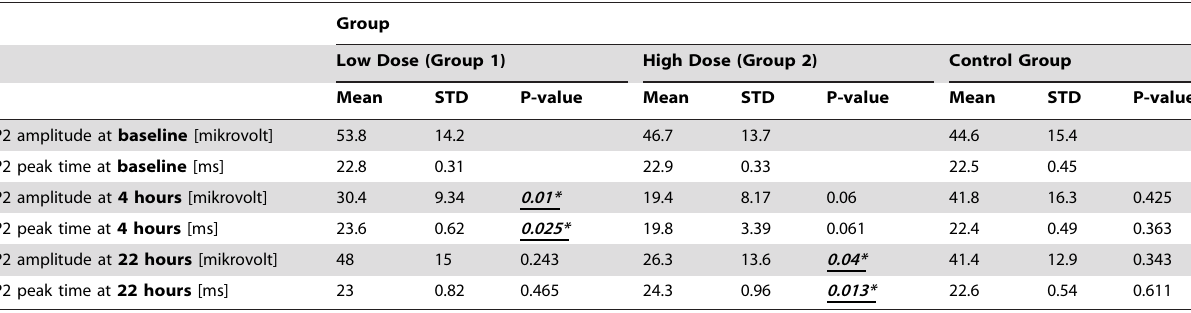
Table 5. Oscillatory